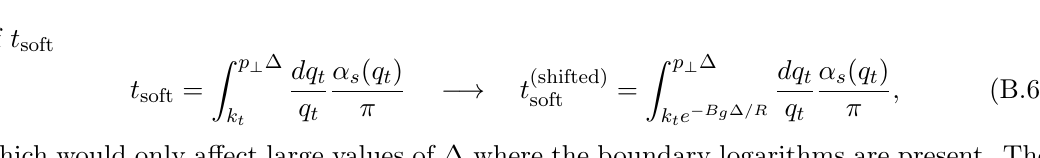
Figure 14. Estimate of the e(cid:11)ect of a hard collinear splitting for the largest-(cid:1) bin of the ATLAS data, using eqs. (B.5) and